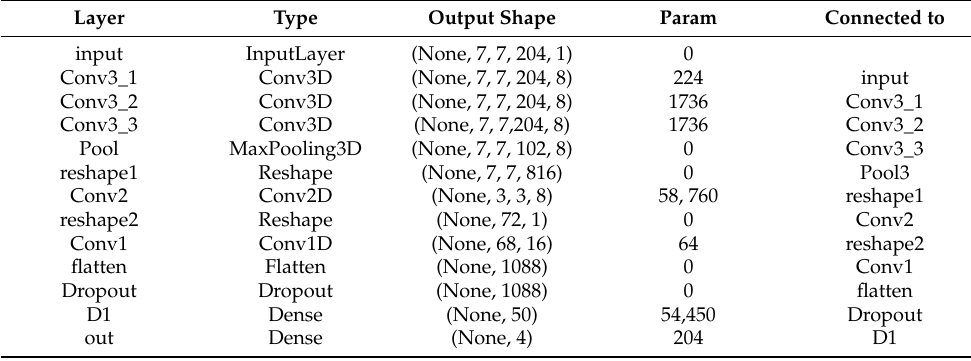
Figure 3. Multidimensional fusion of Atrous-CNN. Table 1. Multidimensional fusion of Atrous-CNN structure.